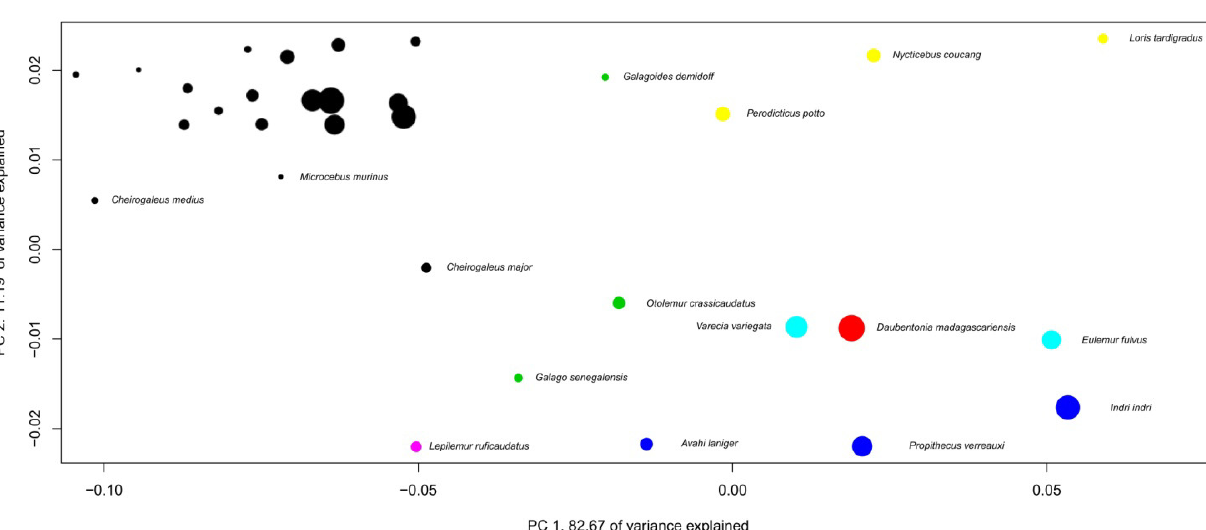
Figure 4. Phylogenetic Principal Component Analysis of prosimians’ brain structure proportions. Regression on independent contrasts of logged absolute brain size onto independent contrasts of position on PC1: Multiple R -squared: 0.489, F -statistic: 13.39 on 1 and 14 DF, P = 0.002575; PC2: Multiple R -squared: 0.143, F -statistic: 2.327 on 1 and 14 DF, P = 0.1494. Families are: black: Cheirogaleidae, red: Daubentoniidae, green: Galagidae, light blue: Lemuridae, dark blue: Indriidae, purple: Lepilemuridae, yellow: